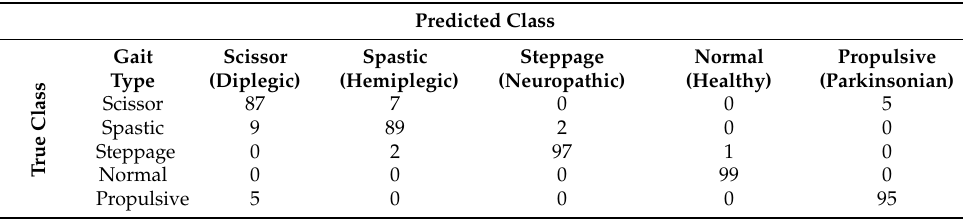
Table 4. Confusion matrix for the proposed gait type classification system representing an average score of GEI and SEI inputs